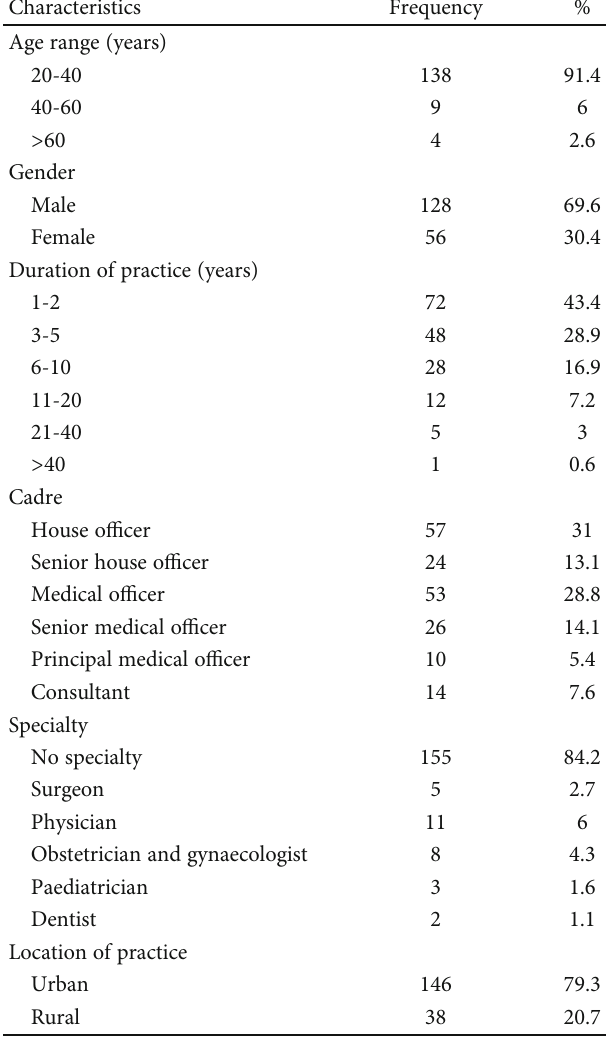
Table 1: Demographic and general characteristics of the